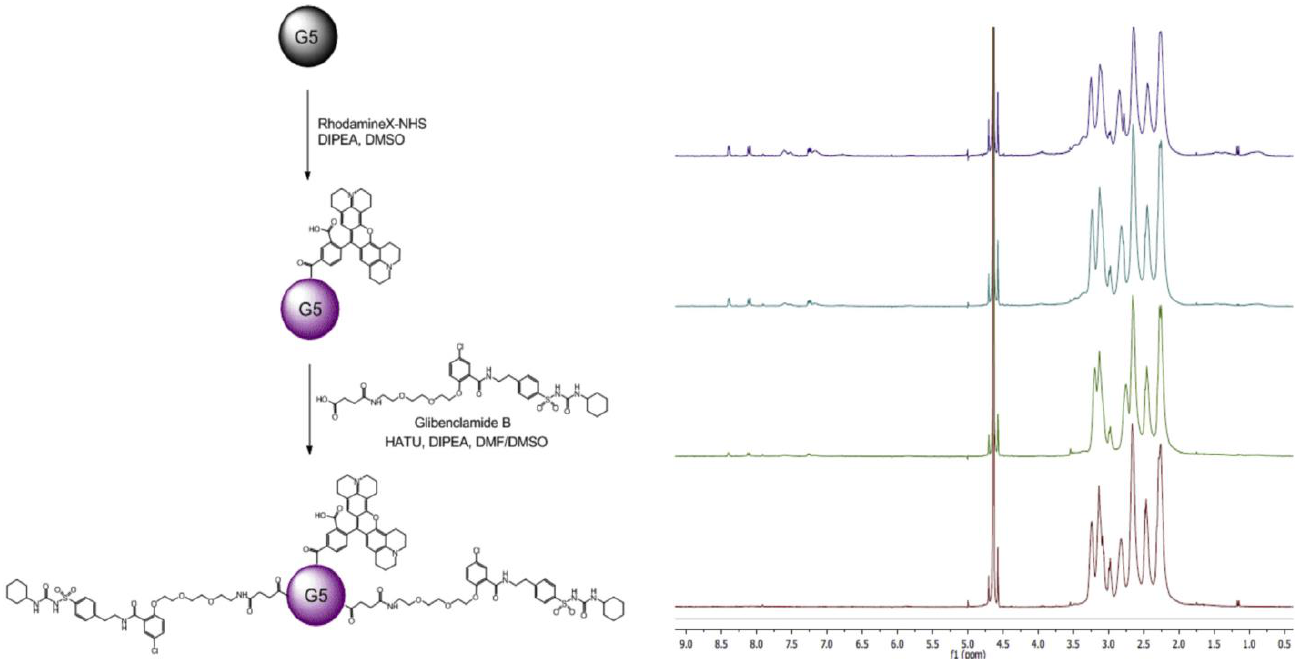
Figure 9. An overview of the synthesis of PAMAM-rhodamine-X-glibenclamide conjugates and a comparison of the 1 H NMR spectra of conjugate probes containing increasing amounts of glibenclamide loading of 0, 2, 5, 15 glibenclamide ligands 12 per dendrimer from bottom to top (right) [161].